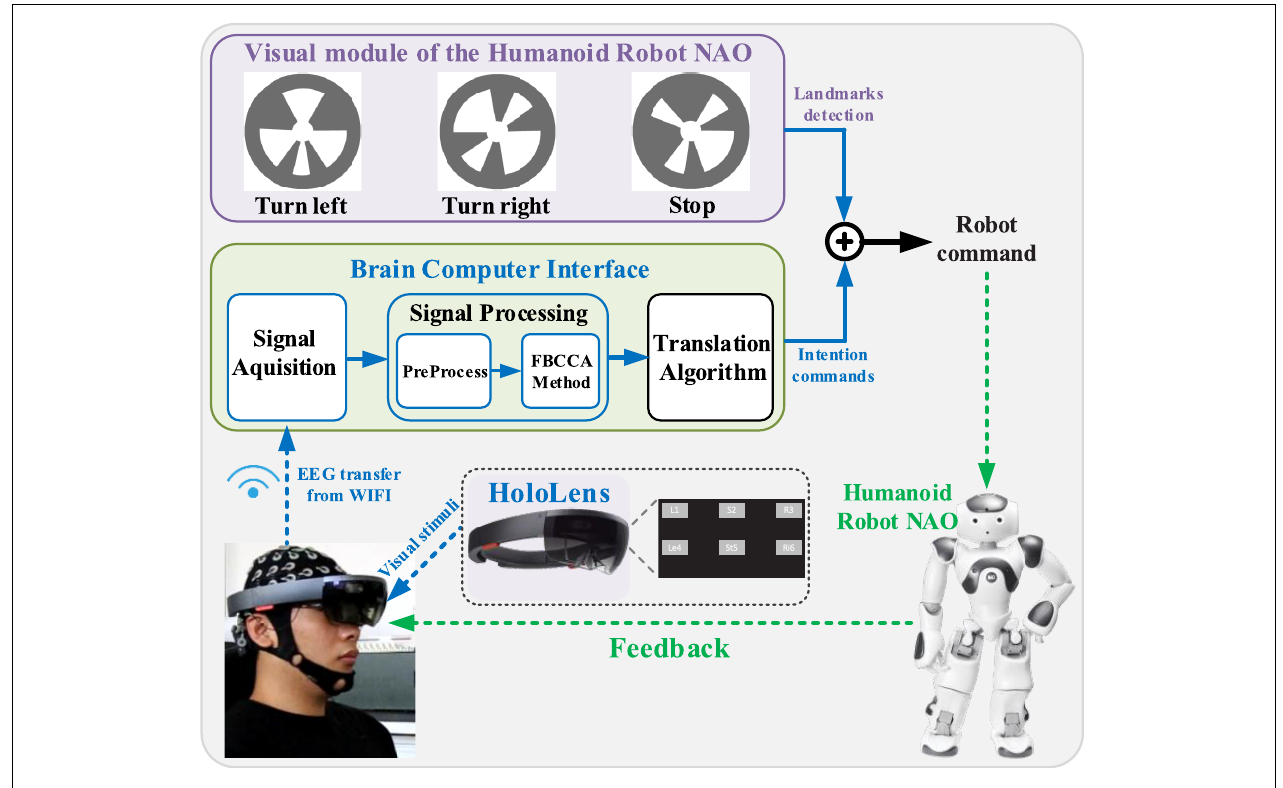
FIGURE 4 | Subjects wired augmented reality equipment for the controlling of a humanoid robot.